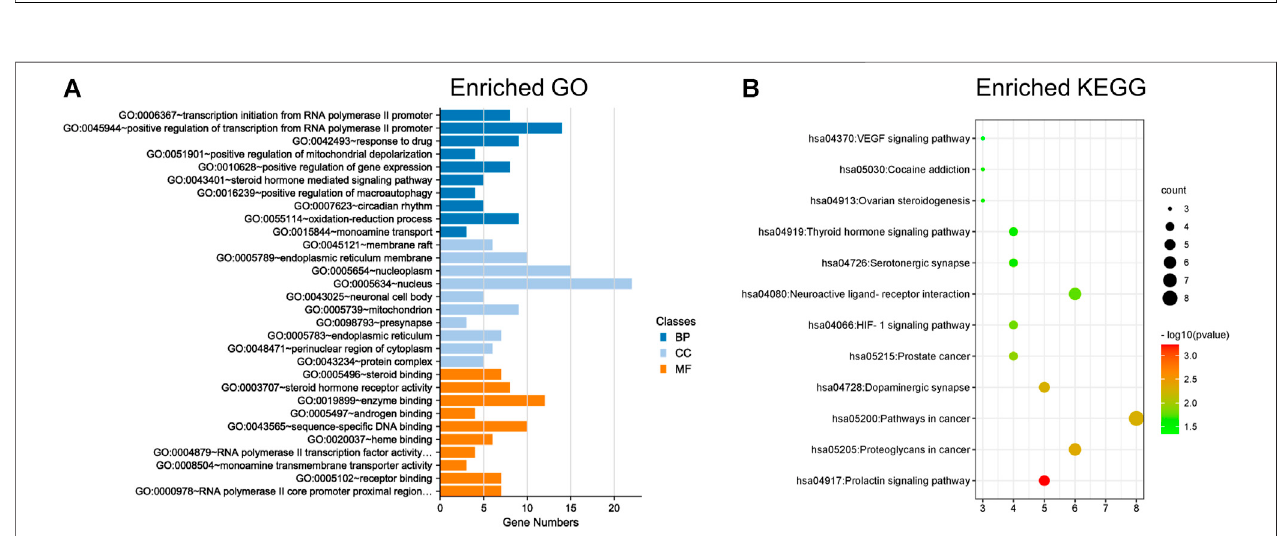
FIGURE 4 | GO and KEGG enrichment analyses of 42 targets for XS volatile oil against menopausal depression. (A) Histogram of the top 10 terms in GO enrichment analysis. (B) Bubble chart of 12 signaling pathways in KEGG enrichment analysis. BP, biological process; CC, cellular component; MF, molecular function.